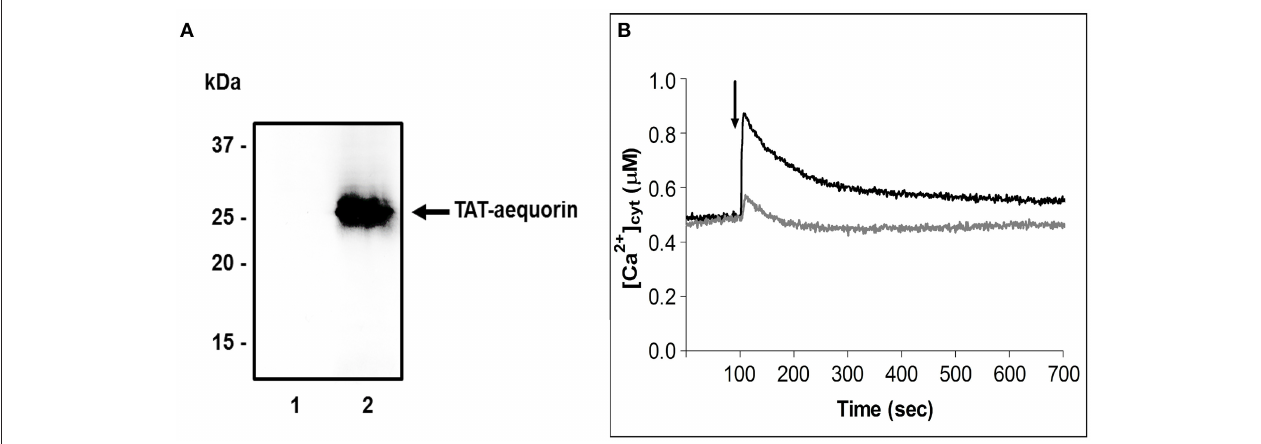
FIGURE 3 | Spm affects cytosolic Ca 2 + concentration in germinating pear pollen. (A) Immunoblot analysis assessing the delivery of TAT-fused aequorin into germinating pollen. Samples were incubated in the absence (1) or presence (2) of TAT-aequorin (30 µ M) for 10min. Total protein extracts (30 µ g) were separated by 12.5% SDS-PAGE, transferred onto PVDF and incubated with an anti-polyHis antibody. (B) Monitoring of cytosolic Ca 2 + dynamics in germinating pollen by using TAT-aequorin. Cytosolic free Ca 2 + concentration ([Ca 2 + ] cyt ) was measured after 10min incubation of germinating pollen with TAT-aequorin and subsequent challenge (arrow, 100s) with either the germination medium (gray trace) or 100 µ M Spm (black trace). Ca 2 + traces are representative of three independent experiments that gave very similar